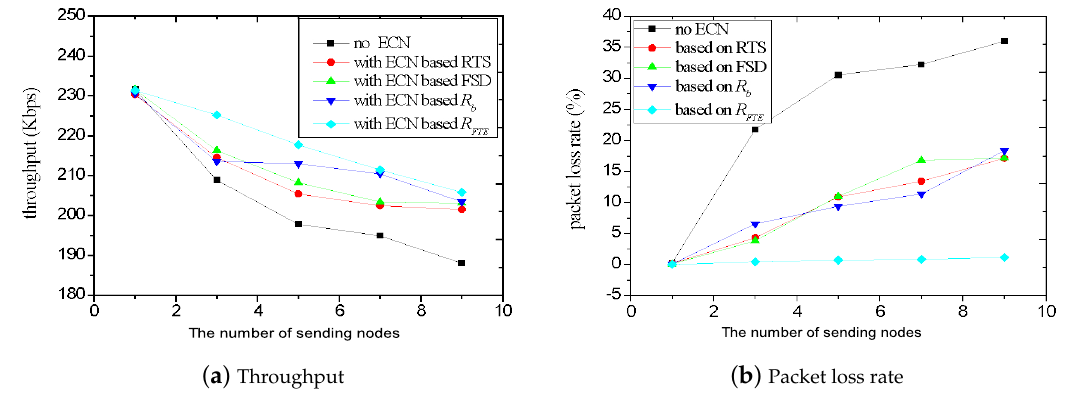
Figure 5. Comparison with other